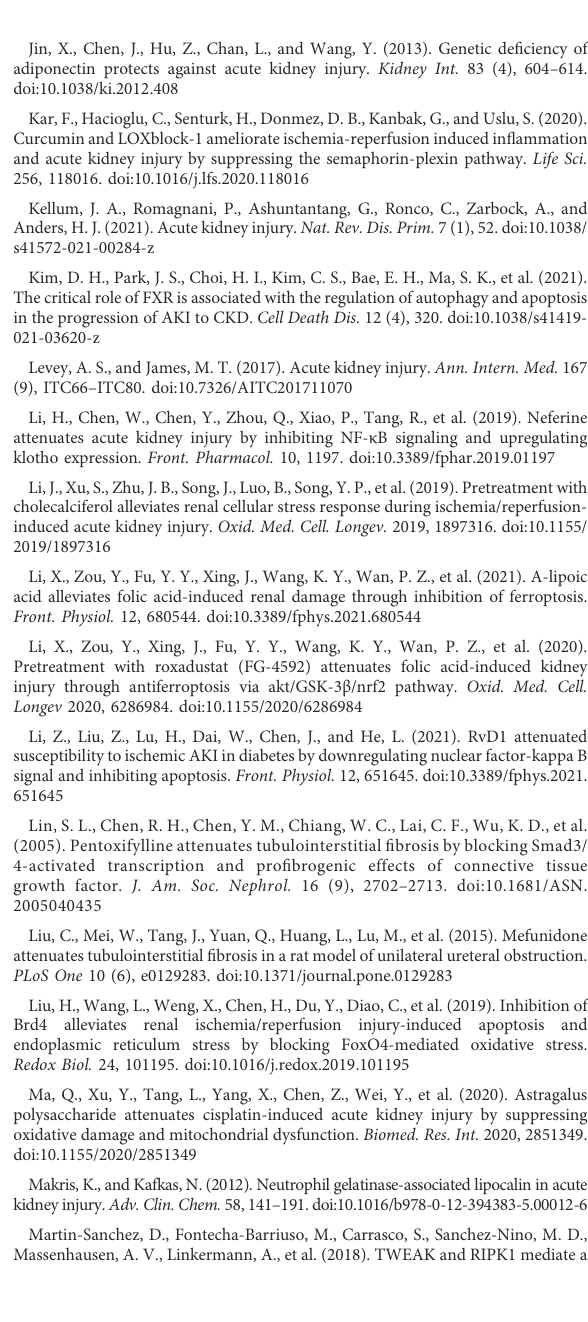
SUPPLEMENTARY FIGURE S1 Mefunidone alleviated kidney fi brosis and inhibited EMT in IRI-induced CKD. (A) HE staining (×200) and tubular injury scores showed protective effect of mefunidone on renal tubular injury on day 14 after IRI modeling. arrows for renal tubular damage. (B) Masson ’ s trichrome staining (×200) and kidney fi brotic scores showed protective effect of mefunidoneon renal tubular injuryon day14 after IRI modeling. arrows for renal tubular damage and renal fi brosis. (C) Histological images of immunohistochemical staining with collagen I and evaluation of CCK-8 was used to explore the optimal drug concentration of